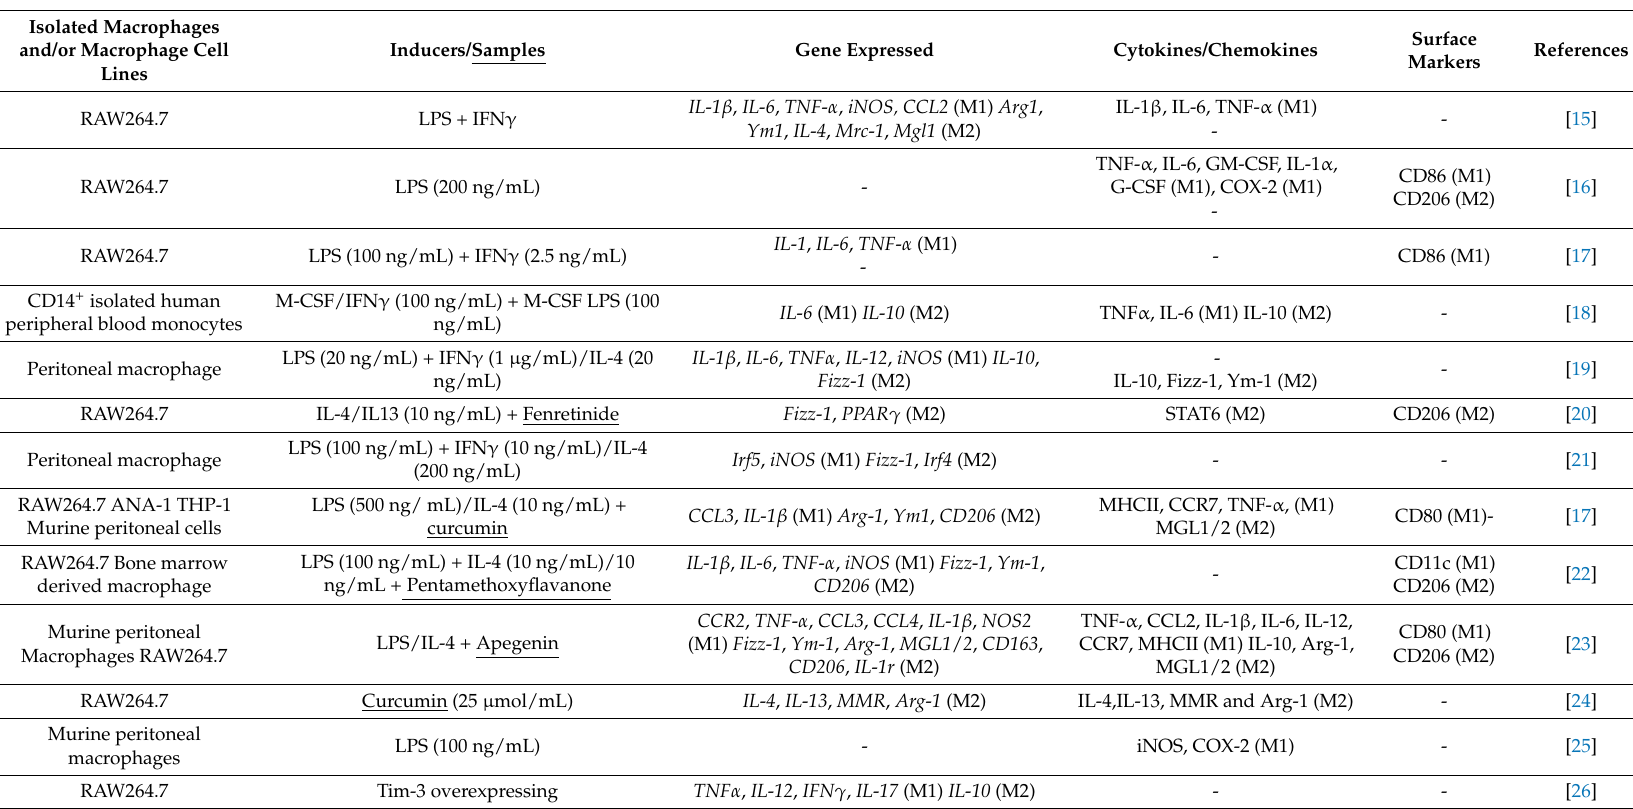
Table 1. Inducers and samples intervened in isolated macrophages and/or macrophage cell lines polarization with genes expressed, cytokines/chemokines produced, and surface markers being observed and used as indicators of polarized macrophages of different states in some recent studies. (Samples intervened were underlined to differentiate with